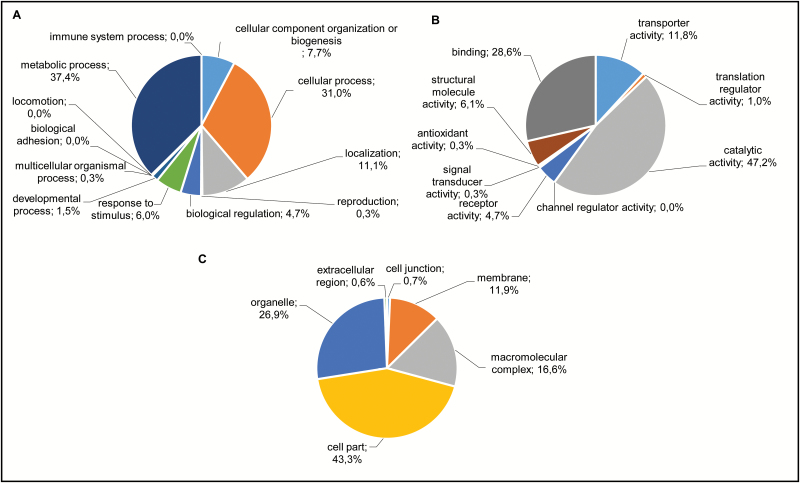
Gene Ontology analyses of all contigs. Pram contigs were assigned to GO slim terms for biological processes (A), molecular functions (B), and cellular components (C) using the PANTHER algorithm (http://www.pantherdb.org) (Mi et al., 2016). Numbers indicate percentages of each GO slim term within main ontologies.